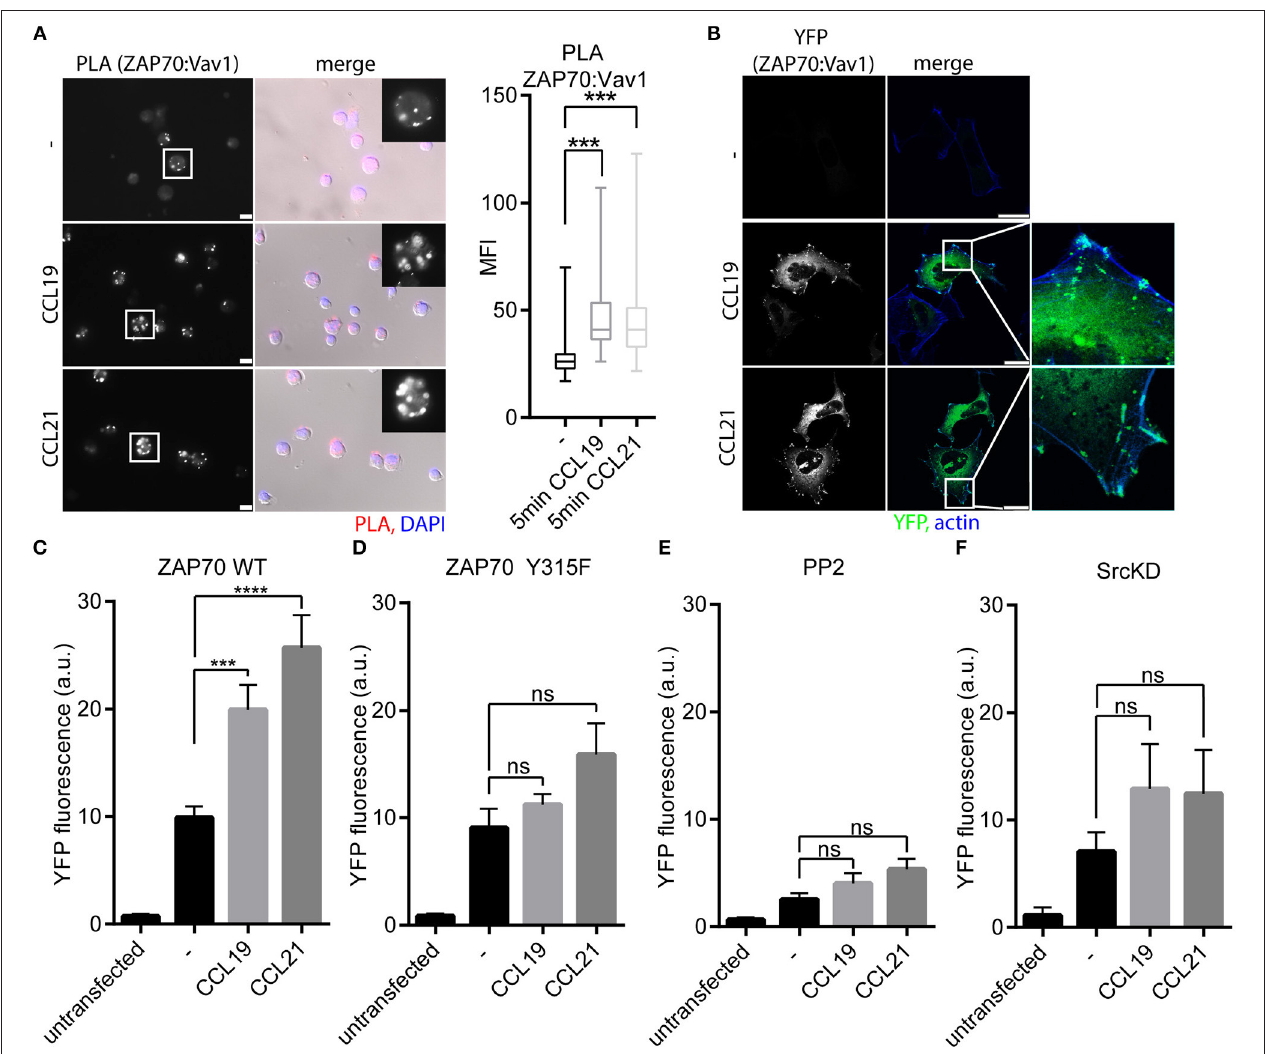
FIGURE 4 | Vav1 recruitment to ZAP70 upon CCR7 stimulation depends on Src kinase and Y315-phosphorylated ZAP70. (A) Micrograph and quantification (box and whisker plot, n > 35 cells) of Vav1-ZAP70 interaction in primary human PBLs assessed by PLA. Cells were stimulated or not with 0.5 µ g/ml CCL19/CCL21 for 15min. Representative epifluorescence images derived from one donor out of three; scale bar, 10 µ m. (B) Confocal images of ZAP70-YFP1:Vav1-YFP2 interaction determined by BiFC in HEK293 cells expressing CCR7-HA upon stimulation with CCL19 or CCL21 (0.5 µ g/ml, 1h). Representative images derived from one out of three independent experiments; scale bar, 25 µ m (C) Quantification of ZAP70-YFP1:Vav1-YFP2 interaction determined by BiFC and flow cytometry in HEK293 cells expressing CCR7-HA stimulated with CCL19 or CCL21 (0.5 µ g/ml, 1h). Mean ± SEM of five independent experiments. (D) Quantification of ZAP70-Y315F-YFP1:Vav1-YFP2 interaction determined by BiFC and flow cytometry in HEK293 cells expressing CCR7-HA stimulated with CCL19 or CCL21 (0.5 µ g/ml, 1h). Mean ± SEM of three independent experiments. (E,F) Quantification of ZAP70-YFP1:Vav1-YFP2 interaction assessed by BiFC and flow cytometry in HEK293 cells expressing CCR7-HA after PP2 (10 µ M) treatment (E) or SrcKD co-transfection (F) . Mean ± SEM of three (F) or four (E) independent experiments. *** p < 0.001; **** p < 0.0001. ns, not